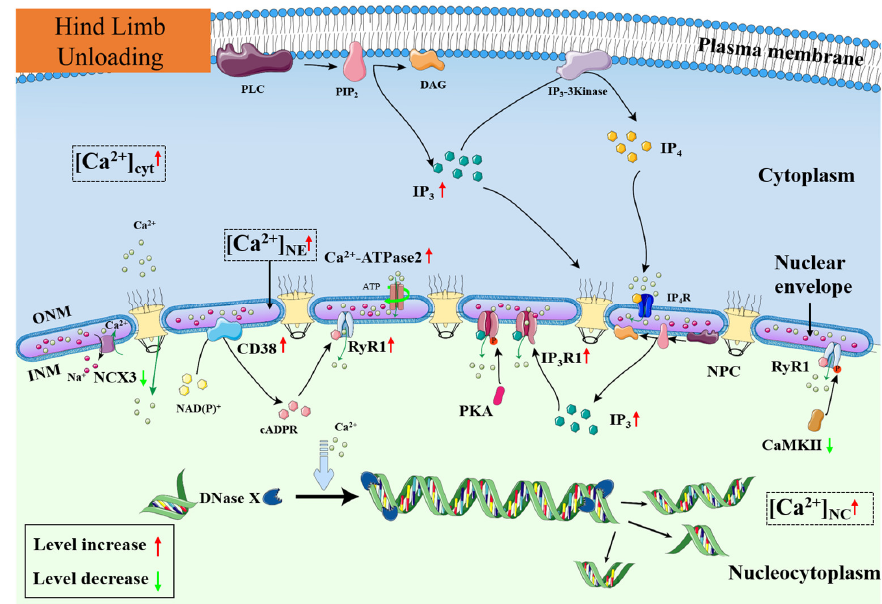
Figure 10. Schematic representation of the regulation changes of nuclear Ca 2+ after hindlimb unloading. ATP: Adenosine triphosphate; Ca 2+ : Calcium ion; [Ca 2+ ] NC : Ca 2+ level in nucleocytoplasm; [Ca 2+ ] NE : Ca 2+ level in nuclear envelope; [Ca 2+ ] cyt : Ca 2+ level in cytoplasm; cADPR: Cyclic ADP-ribose; CaMK II: Ca 2+ /calmodulin dependent protein kinase II; CD38: Cyclic ADP ribose hydrolase; DAG: Diacylglycerol; DNase X: Deoxyribonuclease X; INM: Inner nuclear membrane; IP 3 : Inositol 1,4,5- tetrakisphosphate; IP 4 : Inositol- 1,3,4,5-tetrakisphosphate; IP 3 K: Inositol 1,4,5-tetrakisphosphate Ki- nase; Na + : Sodium ion; NCX3: Na + /Ca 2+ exchanger 3; NE: Nuclear envelope; NPC: Nuclear pore complex; ONM: Outer nuclear membrane; PKA: Protein Kinase A; PIP 2 : Phosphatidylinositol (4,5) bisphosphate; PLC: Phospholipase C; RyR1: Ryanodine receptor 1.